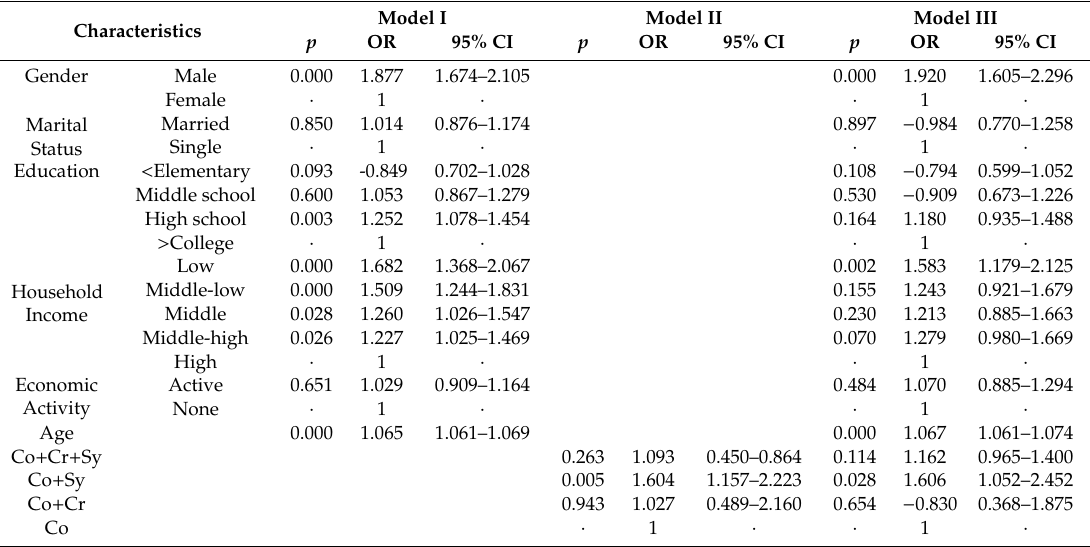
Table 5. E ff ects of the Subjects’ Demographic Characteristics and the Co ff ee Components on the Prevalence of Periodontal